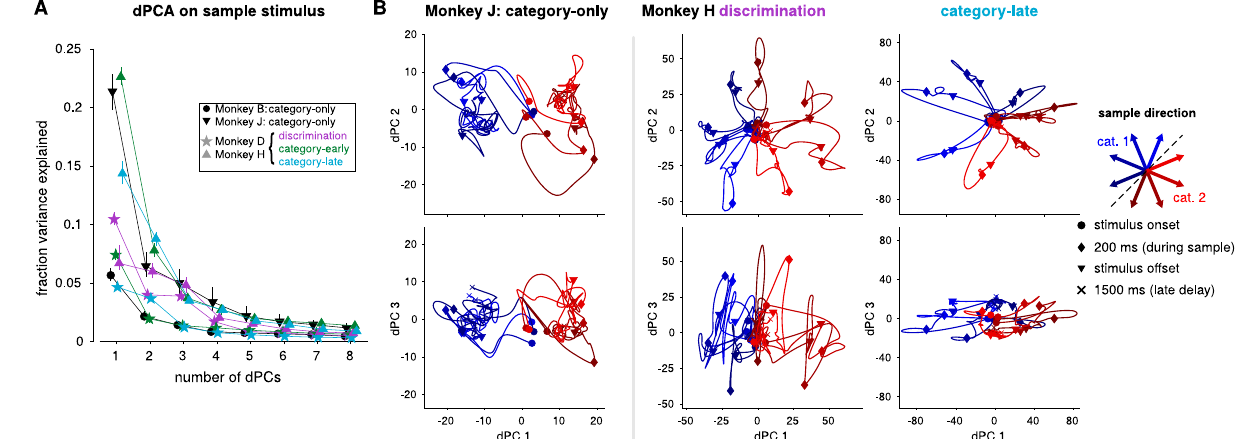
Fig. 6 | Low-dimensional responses to the sample stimulus recovered by dPCA re fl ect stronger motion-direction tuning in pretrained animals than in category-only animals. A The percent of the sample-direction-related activity explainedbyeachstimulusdPC.Mostofthevarianceisexplainedbythe fi rsttwoor three dPCs for all eight populations. Each trace shows the results for a single LIP population. The points denote the medianand error bars show a 95% intervalover bootstraps. B The low-dimensional activity from two LIP populations during the categorization task projected into the fi rst three dPCs for motion direction. Each traceshowsthepopulationresponsetoonesamplestimulusdirection(denotedby color)fromsampleonsetto1500msafterstimulusonset(neartheendofthedelay